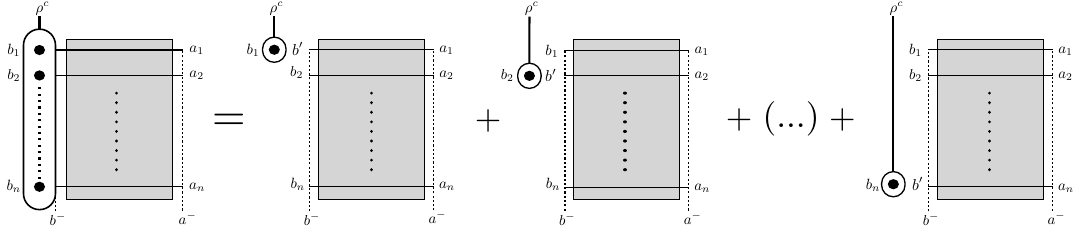
Figure 6 . Schematic representation of eq. (B.9). The circles in the right hand of the equation represent couplings of the external source (cid:26) c to Wilson lines inside the correlator (dark square). Each of these couplings multiplies the correlator by a g(cid:21) ( b (cid:0) ; b previous expression (see (cid:12)gure